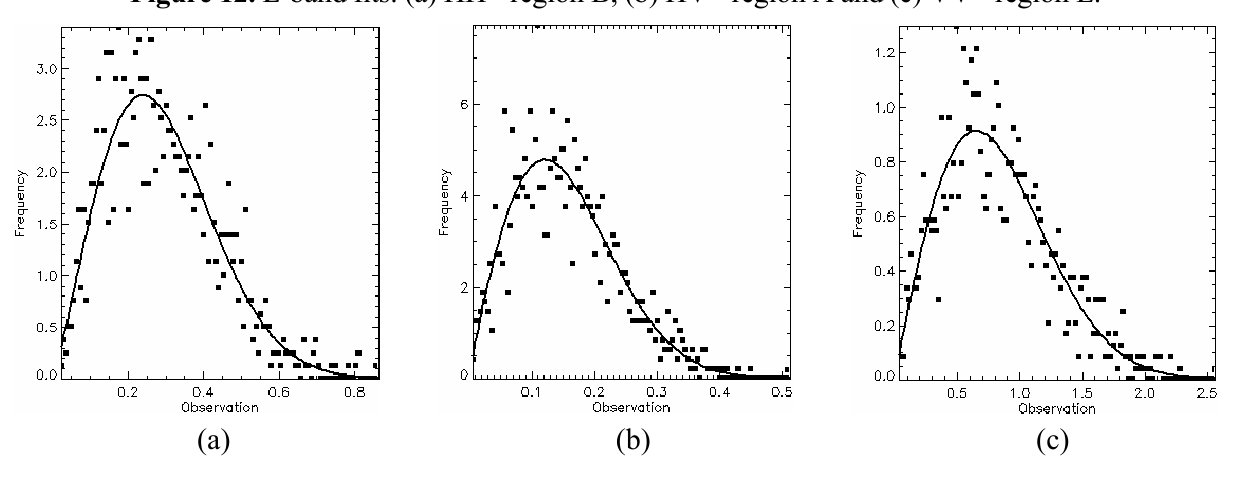
Figure 12. L-band fits: (a) HH - region B, (b) HV - region A and (c) VV - region E.